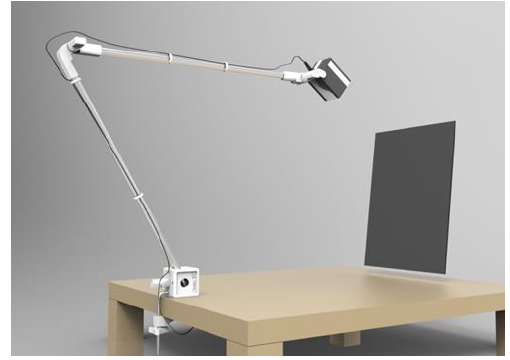
Figure 3. The latest generation of HoLoFoS TM model (λ).